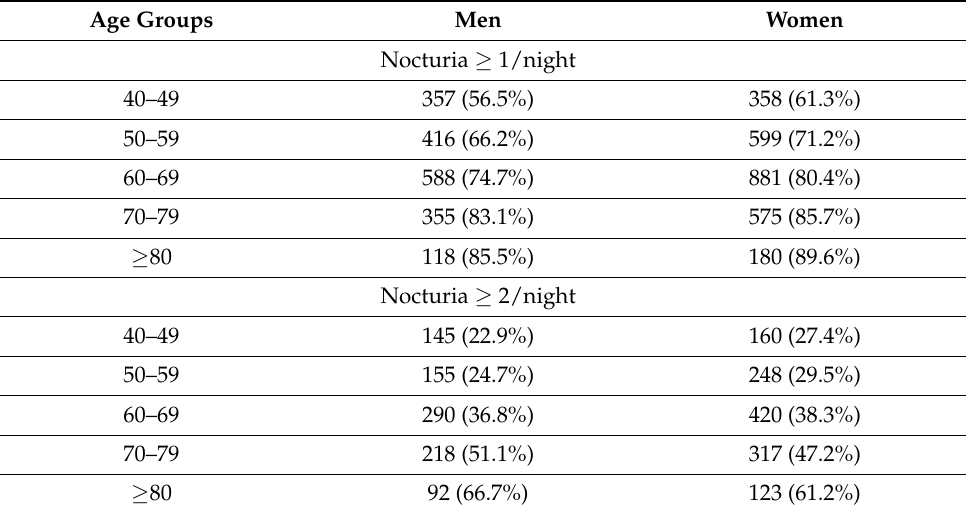
Table 1. Prevalence of nocturia in men and women based on the two thresholds (nocturia ≥ 1/night; nocturia ≥ 2/night) in different age groups.